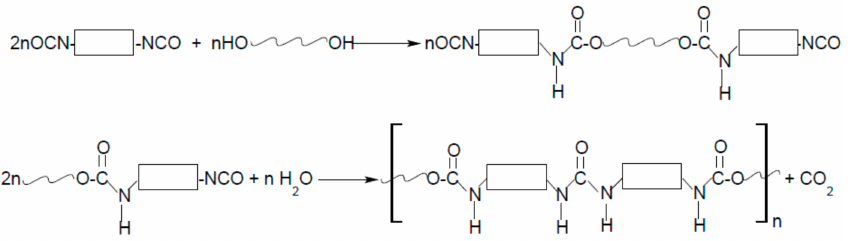
Figure 2. Scheme of polyurethane foam synthesis based on the example of the prepolymer method and with water as a foaming agent.